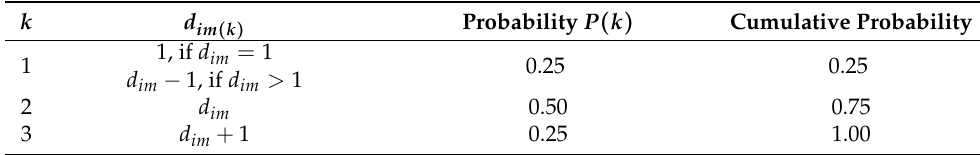
Table 4. Probability distribution of d im ( k )